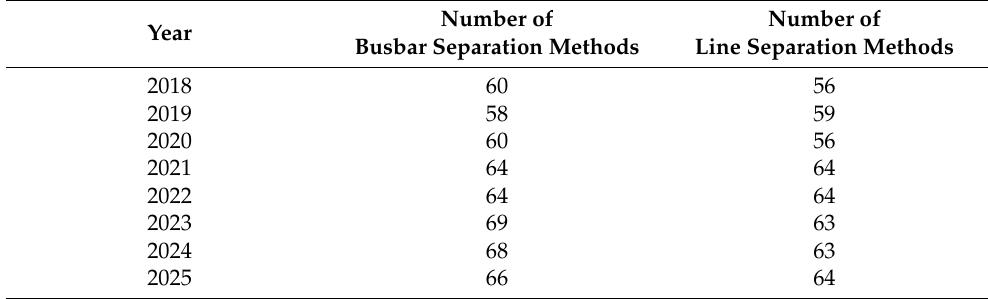
Table 2. Final results for R and S